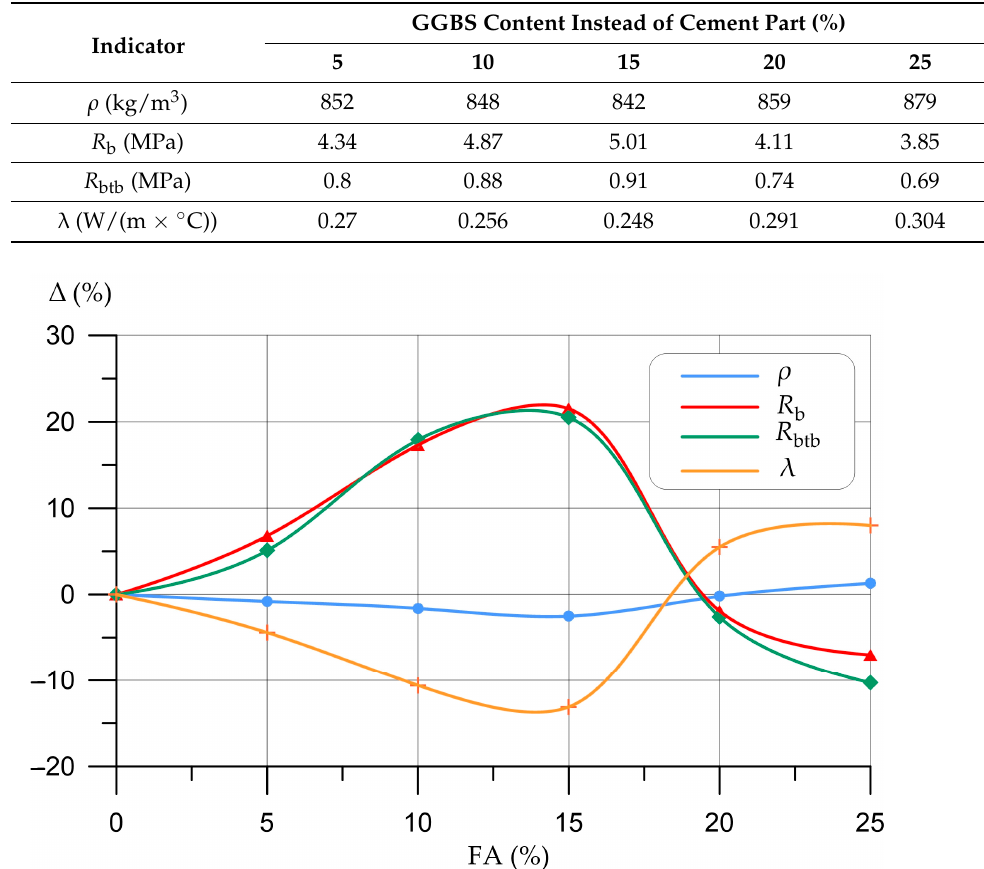
Figure 7. Trends in the physical and mechanical characteristics of non-autoclaved aerated concrete modified with FA.